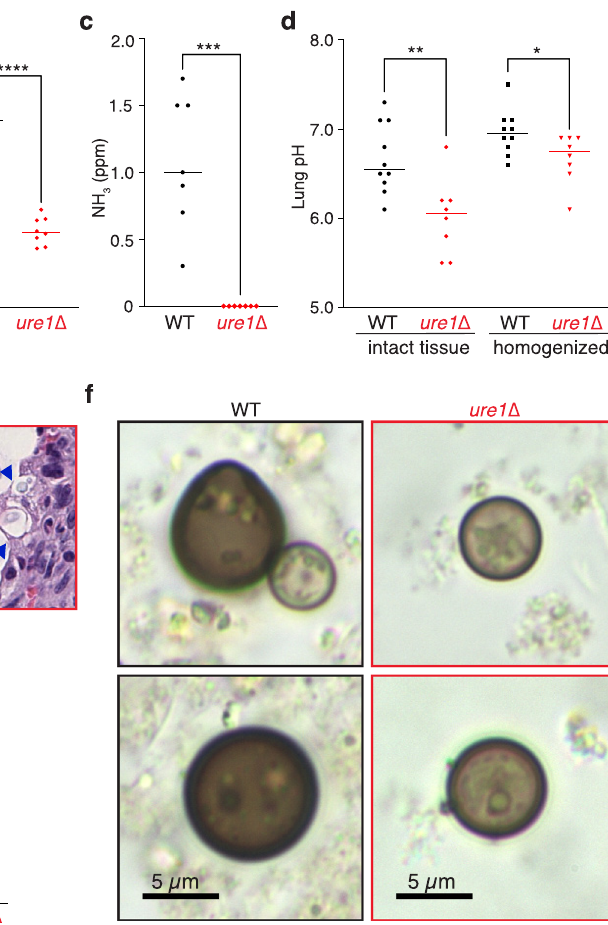
Fig.4|Pulmonarymurineinfectionmodelrevealsurease-dependentammonia production and increased pH and melanization in lung tissue. a Intranasal infection resulted in a signi fi cantly higher fungal burden in both the lungs and brains of mice infected with WT ( n =10) compared to ure1 Δ ( n =8, lung; n =6, brain). **** p <0.0001; unpaired, two-sided parametric t -test. b Lung mass was also signi fi cantly higher for mice infected intranasally with WT compared to ure1 Δ . n =10, WT; n =8, ure1 Δ , **** p <0.0001; unpaired, two-sided parametric t -test. c AmmonialevelsmeasuredintheexhalantofWT-or ure1 Δ -infectedmiceenclosed ina55cm 3 enclosurefor2min. n =7,*** p =0.0001;unpaired,two-sidedparametric t -test. d Lung tissue pH measured using an MI-407 needle electrode immediately after dissection and after homogenization and centrifugation of tissue was